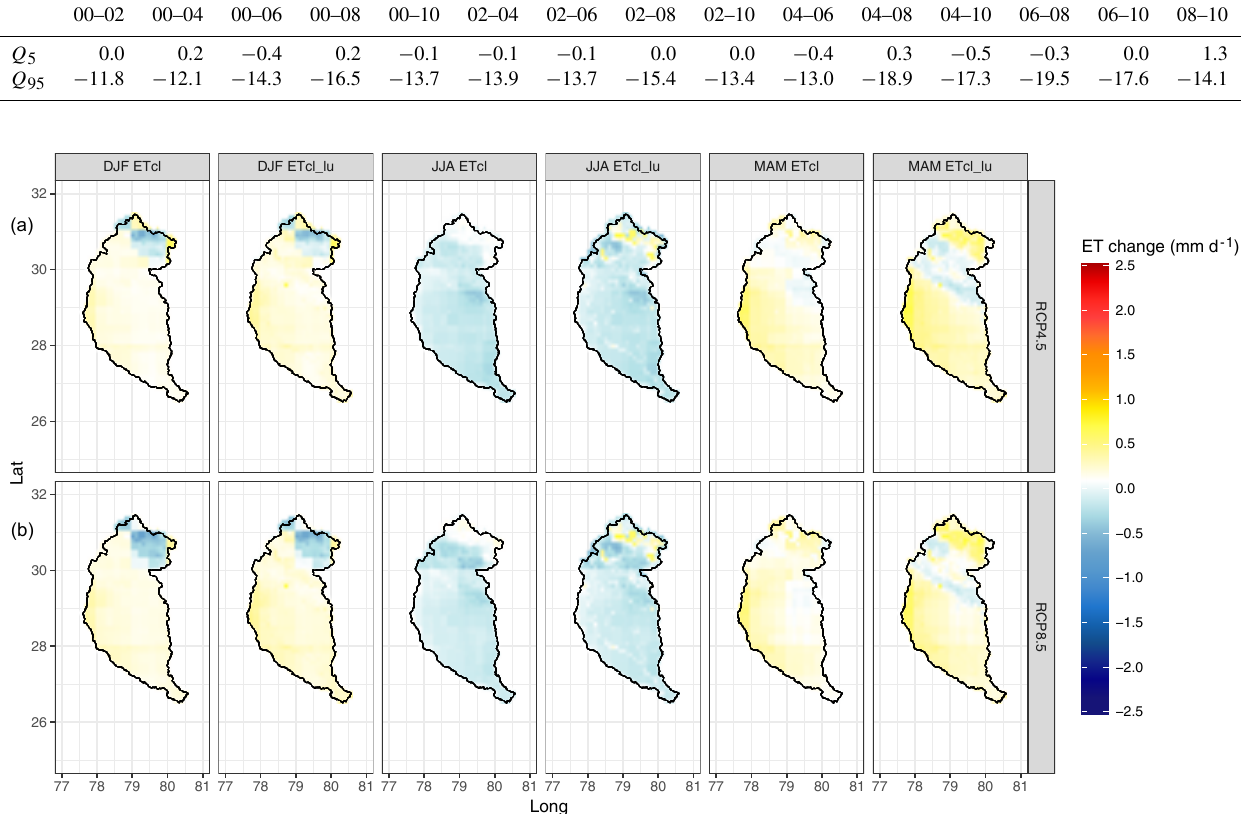
Figure 10. Absolute changes in spatial evapotranspiration (ET) fluxes between the historical simulation period 2000–2005 and the future projection simulation period 2030–2035 for the Upper Ganges basin and for each of the emission scenarios (RCP4.5 and RCP8.5). Results are split into 3-month period seasonalities for winter (DJF), spring (MAM) and summer (JJA) under the two types of experiments: (a) only climate change is taken into account (ETcl) and (b) both climate change and land-use change are taken into account